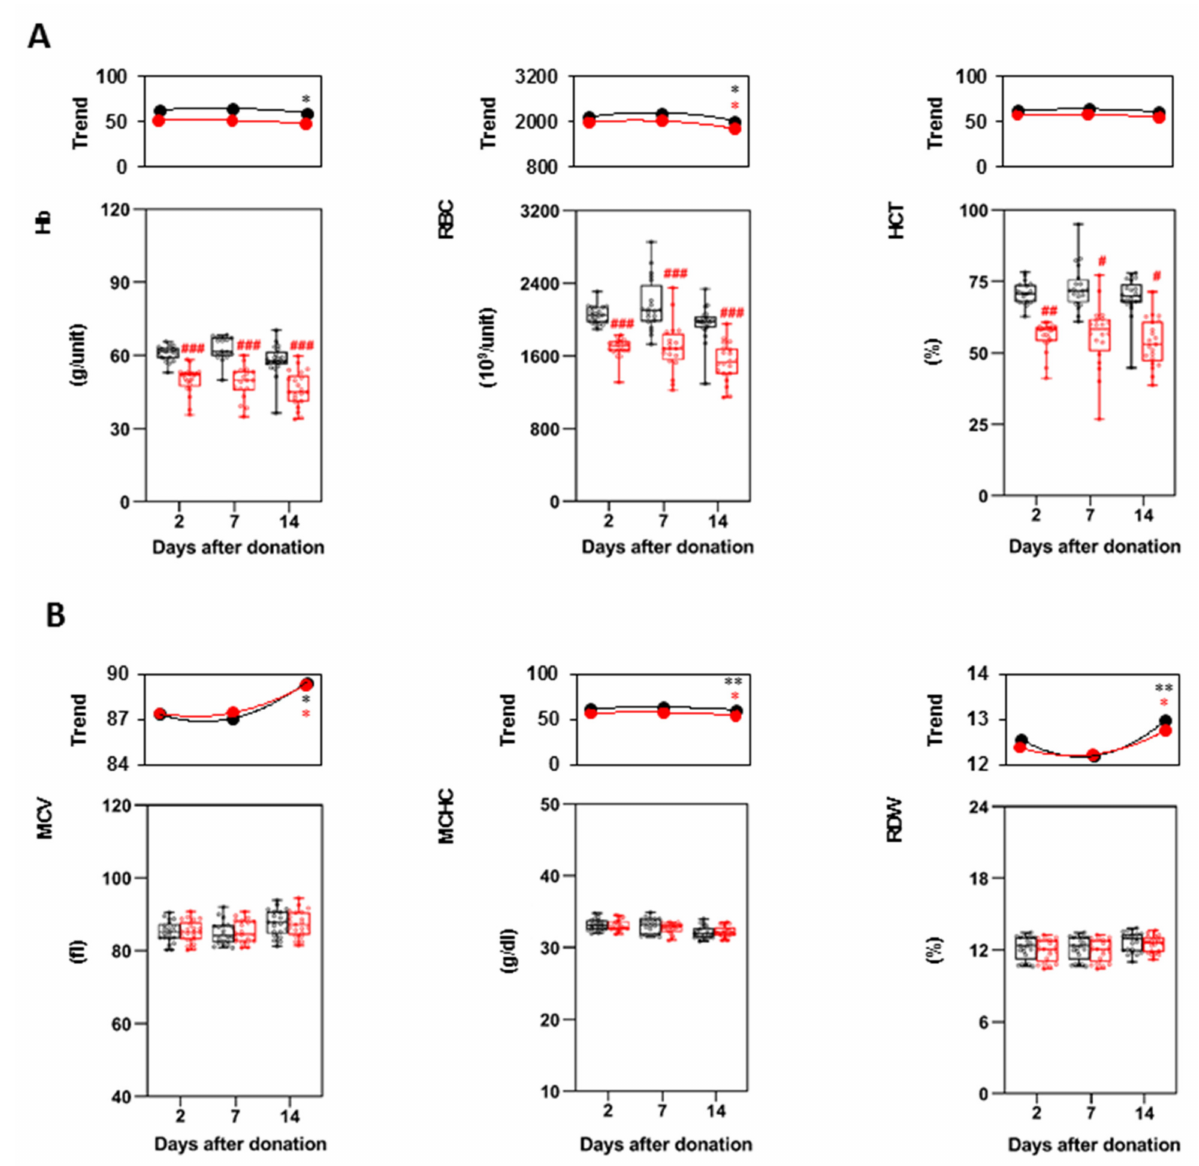
Figure 2. Box plots with single values of RBCs indices at 2, 7 and 14 days of storage. ( A ) Hb, RBCs, HCT values; ( B ) MCV, MCHC and RDW. Method 1 is in black, method 2 in red. The boxplots represent the interquartile range, while the internal line indicates the median; the whiskers span from minimum to maximum. N = 20 single samples are represented for each condition. Points and lines in the top panel indicated means of the box plot values and their trend lines during storage, asterisks highlight significant differences between two consecutive time points Red # indicate significant differences between the two methods at the different time points, Black * indicate significant differences of the same method at two consecutive time points. # and * p < 0.05, ## and ** p < 0.01, ### p <